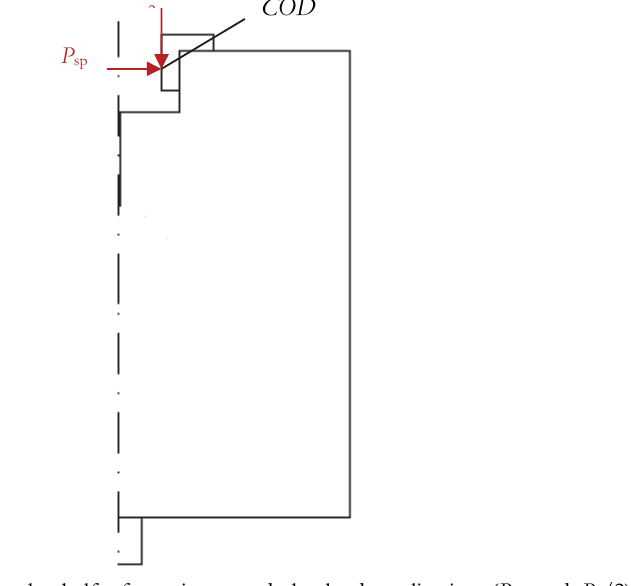
Figure 2: Detail of boundary conditions, see the half of specimen and the load application ( P sp and P v /2) with crack opening displacement ( COD ), position at load